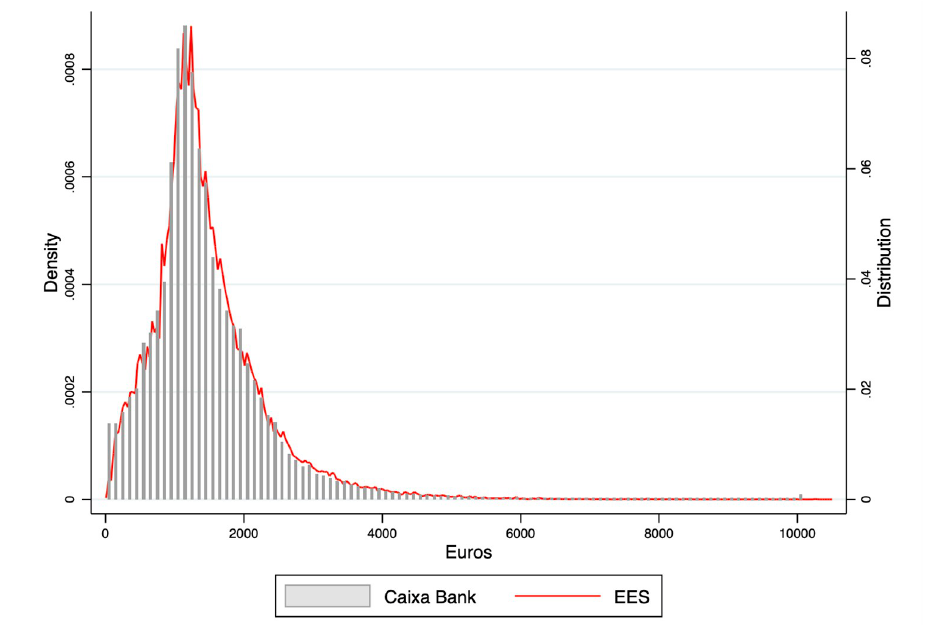
Fig 1. Distribution of monthly net wages: Our sample (CABK) versus the sample of the official wage survey (EES).